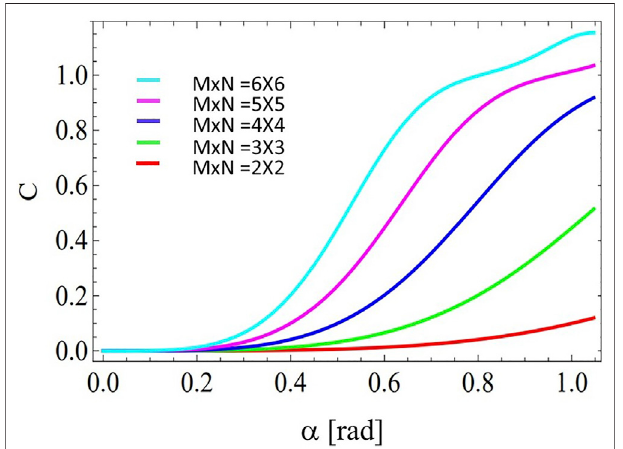
FIGURE 3 | Concurrence vs. angular aperture size for different path dimensions( M × N ) and aperture sizesinthe range [0, 2 π / N max ] with N max = 6. Details are in the text.